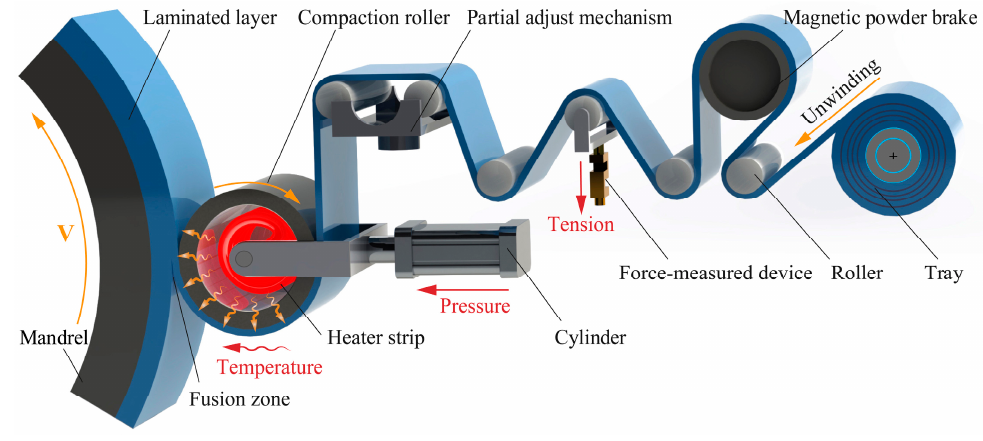
Figure 1. Schematic of composites prepreg tape winding process.